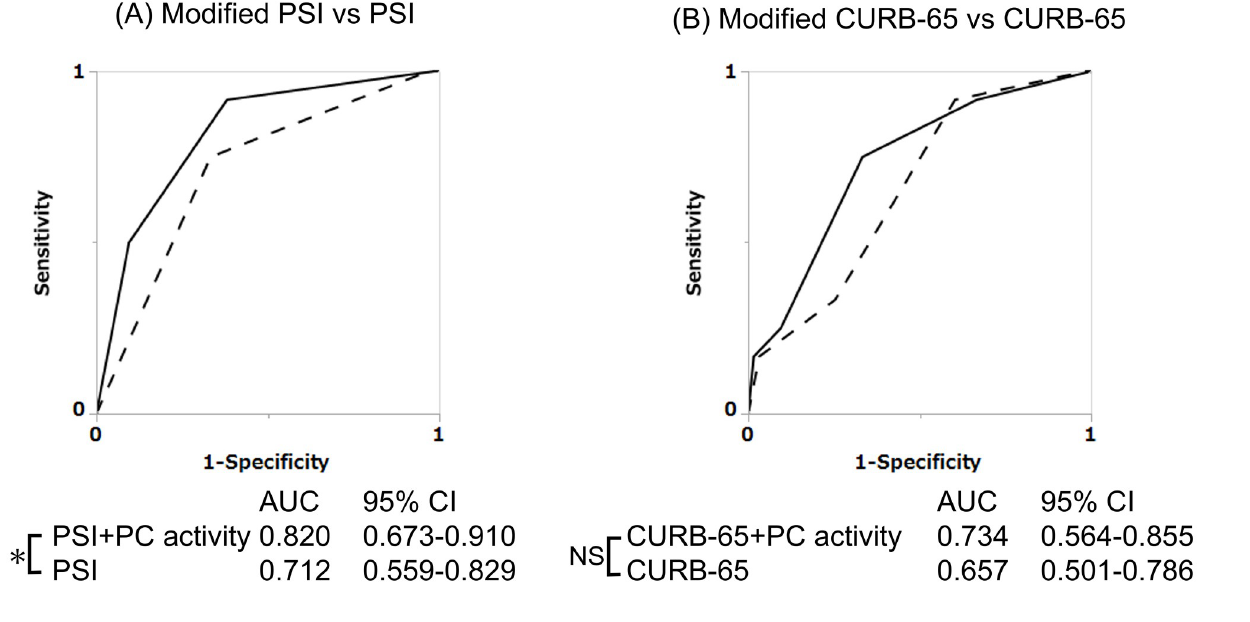
Fig 5. Additional effects of PC activity with PSI or CURB-65 for prognosis of NHAP. Dashed lines represent original PSI or CURB-65 as shown with solid lines in Fig 1. Solid lines are additional examination of PC activity. We added 25 points to the PSI score if the patient showed PC activity < 55%, and reclassified the patient based on the rescored PSI into classes 1–6. Classes 1–4 are the same as in the original PSI classification. Patients with modified PSI scores � 130 were divided into class 5 for scores within 130–159 or class 6 for scores � 160. The modified PSI class had a significantly higher AUC for mortality compared to that of the original PSI classes (p = 0.036) (A). For CURB-65, 1 point was added to the CURB-65 when PC activity was < 55%, making 6 the maximum total score